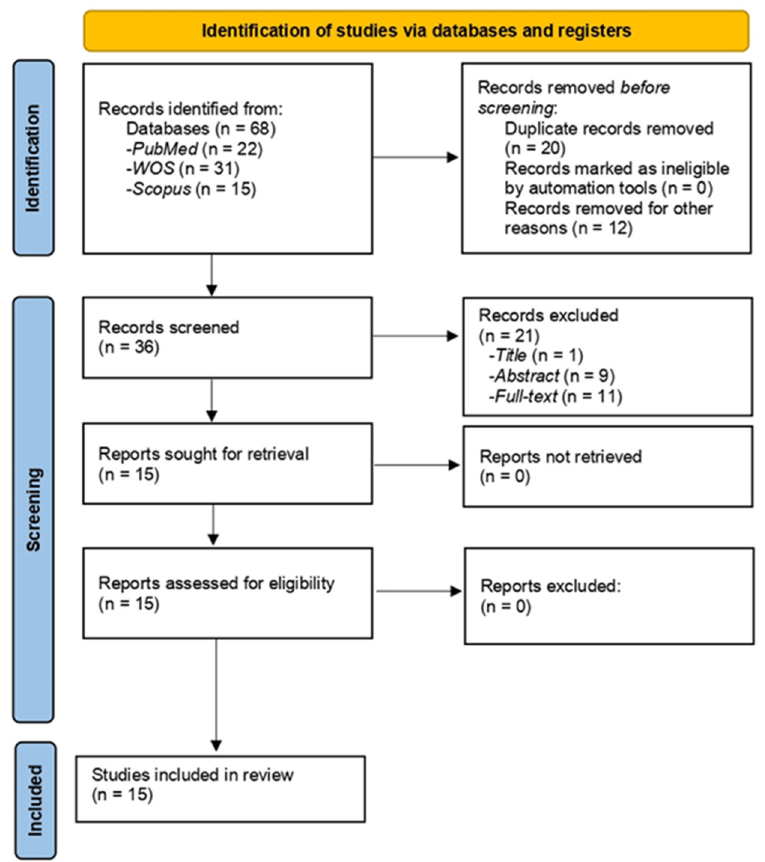
Figure 1. Flow diagram of Chronic Pain and Emotional Stroop (PRISMA).